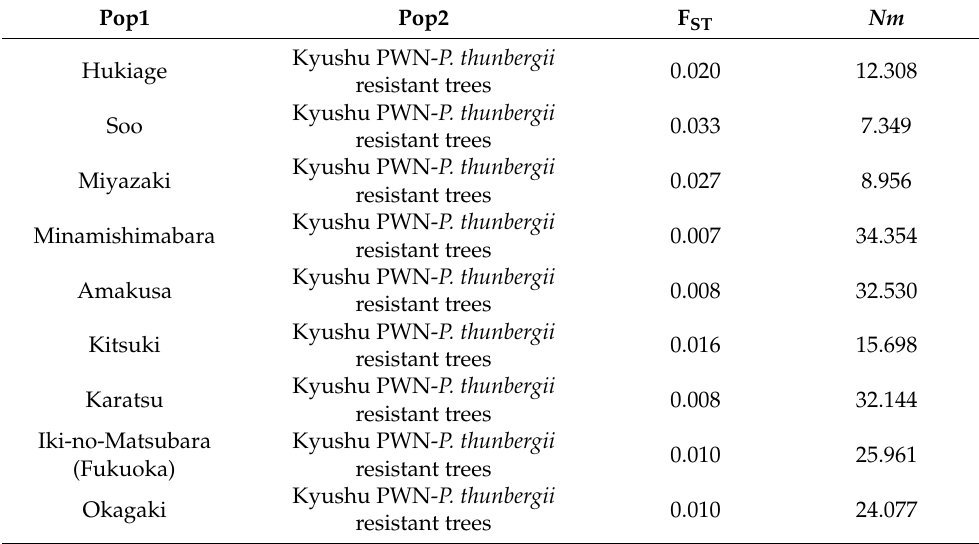
Table A3. Gene flow (Nm) of Kyushu PWN- P. thunbergii resistant trees with the populations within Kyushu